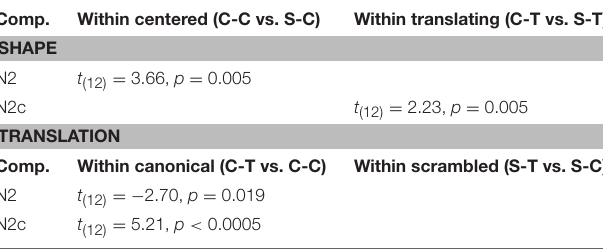
TABLE 3 | Post-hocs analysis of shape and translation factors. Comp.